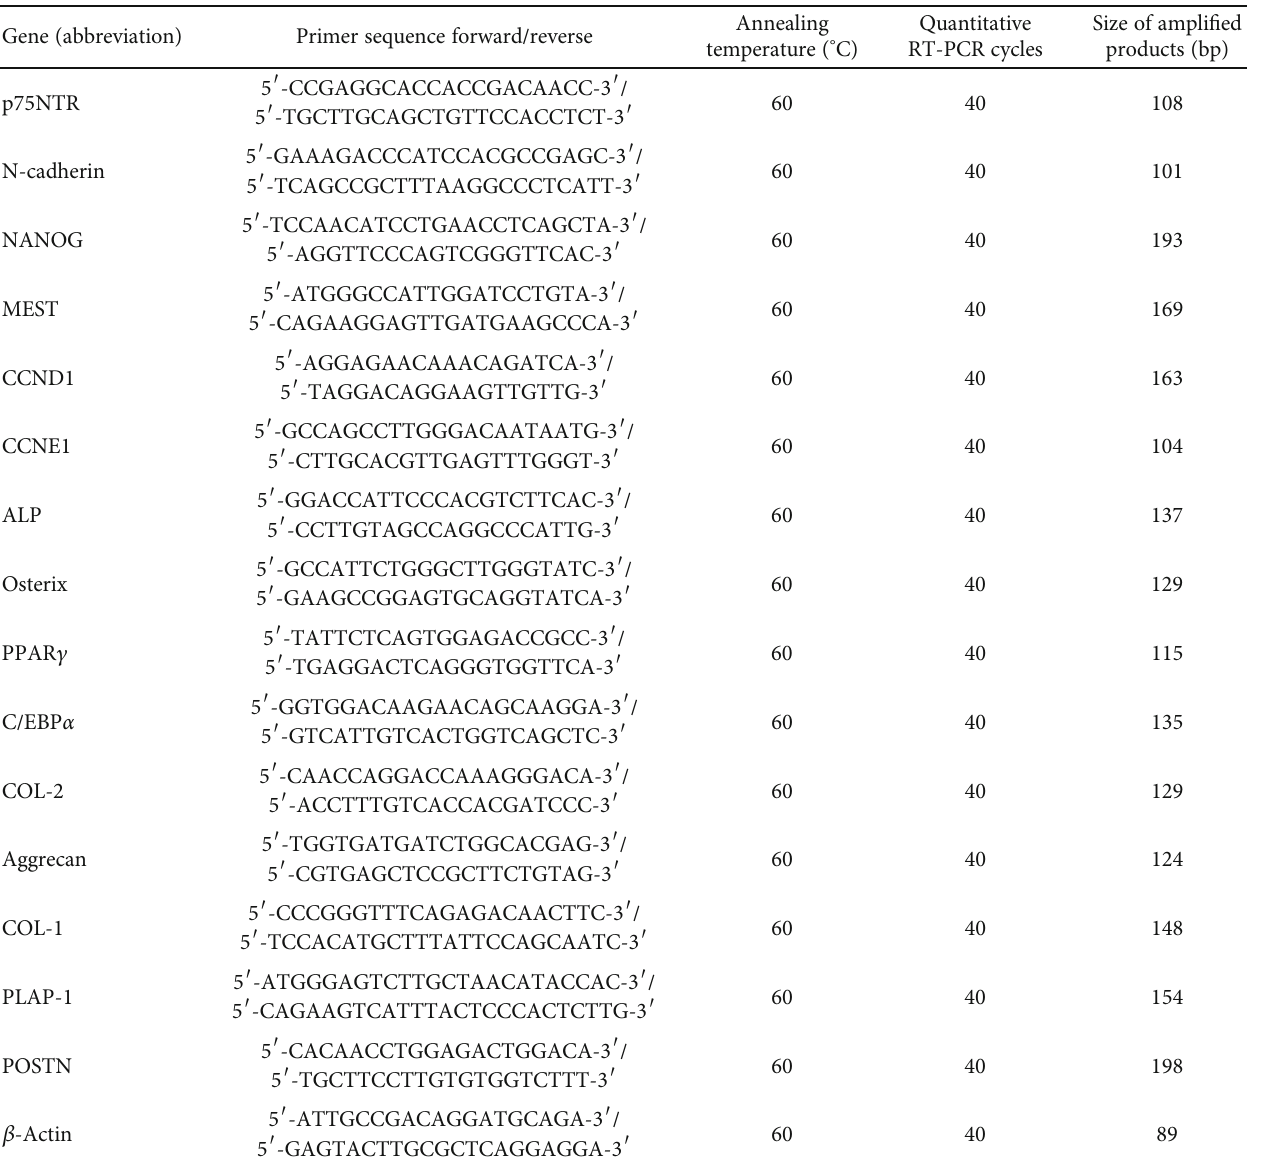
Table 2: Primer sequences, annealing temperatures, cycle numbers, and product sizes for quantitative RT-PCR. Gene